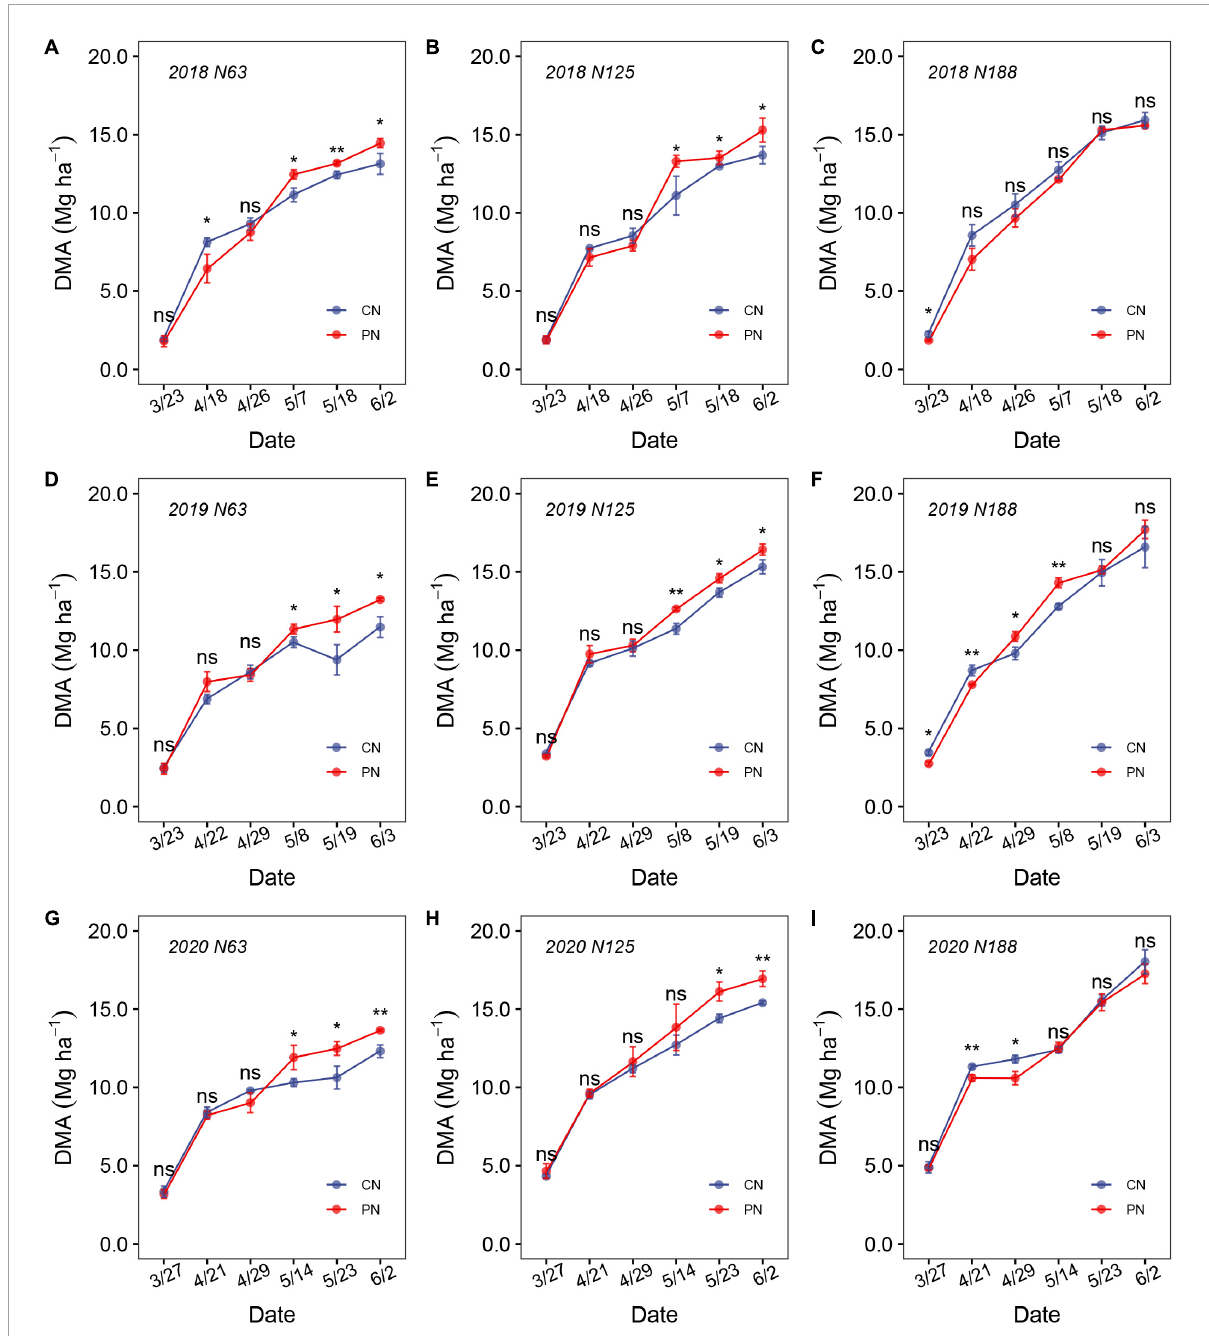
FIGURE4 Dynamic variation in biomass accumulation from the jointing to ripening stages at N63 (A,D,G) , N125 (B,E,H) , and N188 (C,F,I) under the control (CN) and poly(aspartic acid)-coated urea (PN) treatments during the 2017–2018 (A–C) , 2018–2019 (D–F) and 2019–2020 (G–I) growing seasons. (ns means not significant, “*” and “**” above the columns indicate significance at the p = 0.05 and p = 0.01 levels, respectively, within a